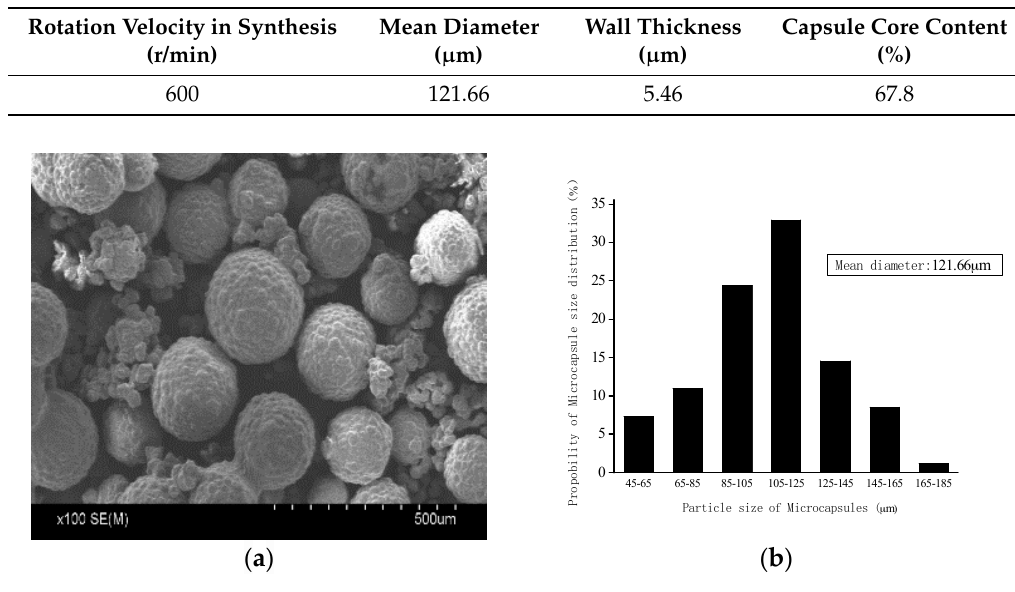
Figure 1. Organic microcapsules: ( a ) SEM images of the microcapsules; ( b ) Particle-size distribution of the microcapsules.